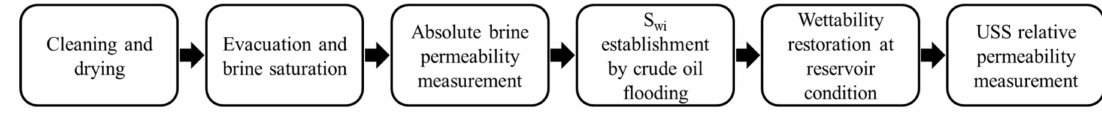
Figure 18. Steps to core sample preparation.